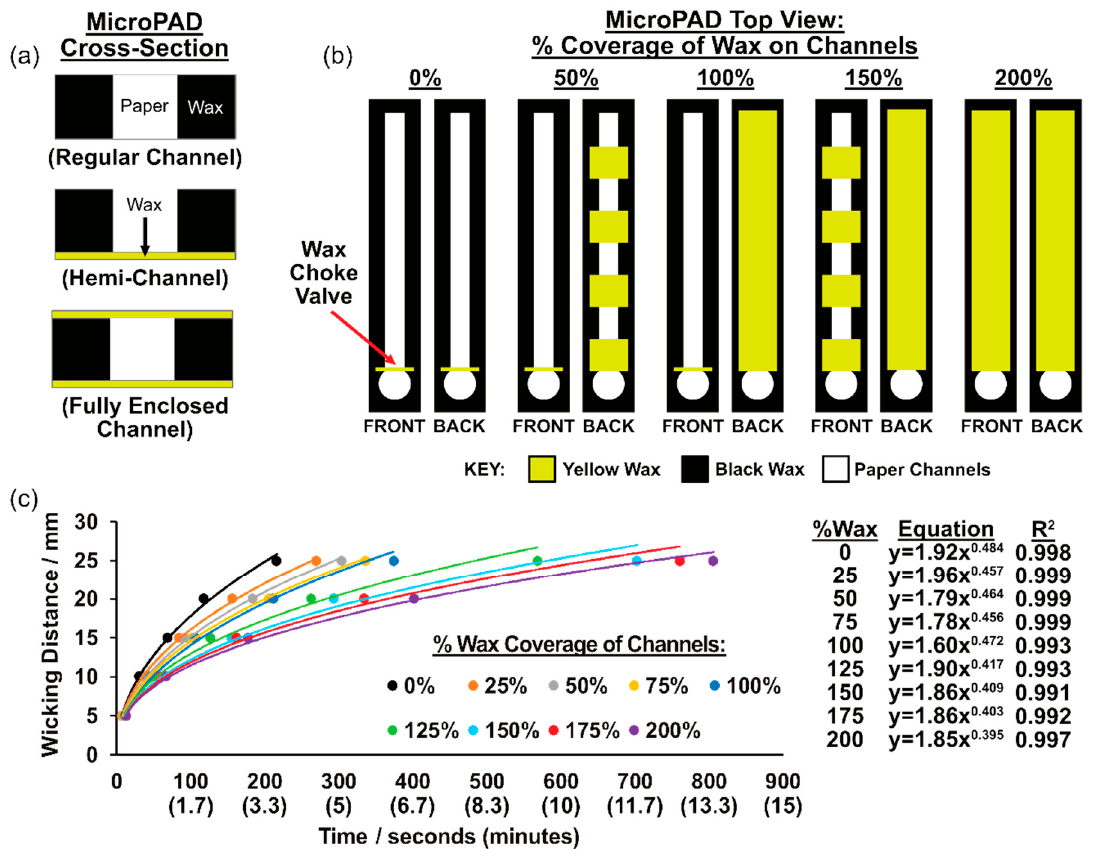
Figure 1. Paper-based channels with wax-printed fluidic time delays. ( a ) Diagram of MicroPAD cross-section displaying regular channels (exposed to ambient environment), hemi-channels (wax on one side), and fully-enclosed channels (wax on both sides). ( b ) MicroPAD top view diagram (front & back sides). The black wax represents a standard microPAD channel, while the yellow wax represents fluidic time delays (measured as % coverage of the paper channel). As shown, a fully-enclosed channel was defined as 200% wax coverage. The wax choke valve (not accounted for in % wax channel coverage calculation) was used to direct the fluid into the paper channel and prevent wicking along the top surface of the paper, which can negate the time delay effects of the wax printed features. ( c ) Graph of wicking distance over time (channel width = 3 mm, n = 3). A greater percentage wax coverage of channels resulted in decreased wicking rates. For example, it took 806 s (~13.4 min) for fluid to wick 25 mm in a 200% covered channel, and 216 s (~3.6 min) in a standard channel. Error bars were omitted for clarity, please see Table A1 for exact values and standard error.